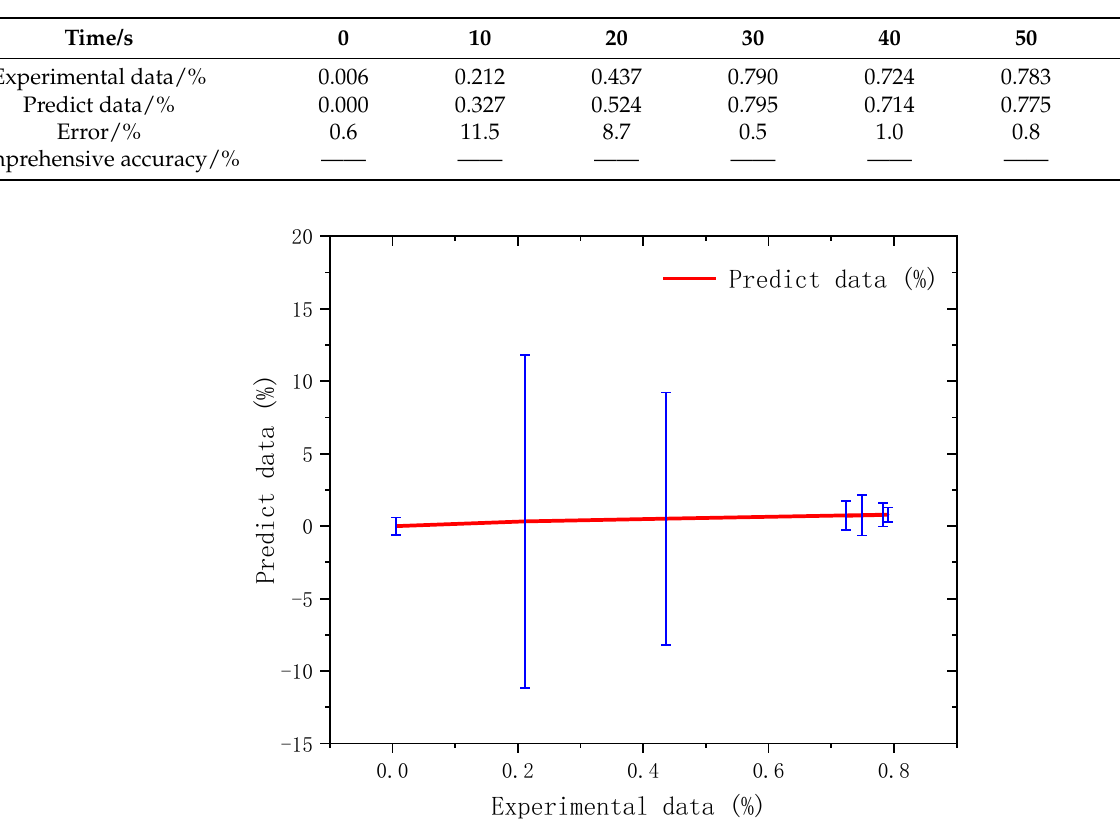
Figure 6. ( a ) Training process curve of a BP neural network; ( b ) neural network predictions. Table 4. Neural network prediction of elemental concentrations.